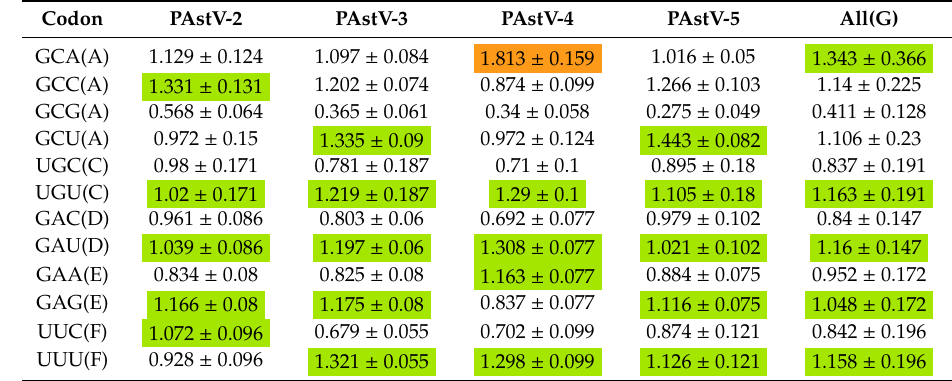
Table 2. The relative synonymous codon usage (RSCU) of the CDS of PAstV strains. RSCU values of 59 synonymous codons excluding codons for Met and Trp are presented. The letter in brackets represents the abbreviation of the corresponding amino acid. The numbers of preferentially used synonymous codons are highlighted in green and orange colors. The RSCU values of the over-represented (RSCU > 1.6) codons are shaded using orange